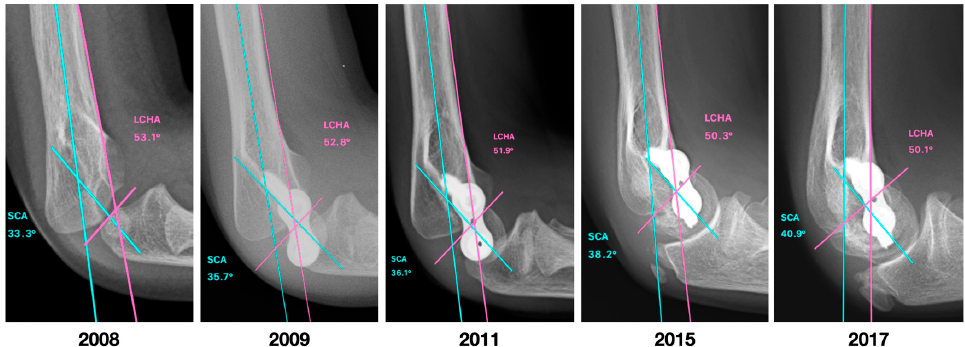
Figure 6. Patient treated with LDHH at the age of 3 years and 5 months, and radiographic images obtained over the following 10 years until the correction of the arm axis. BA, Baumann angle; HUA, humero-ulnar angle.